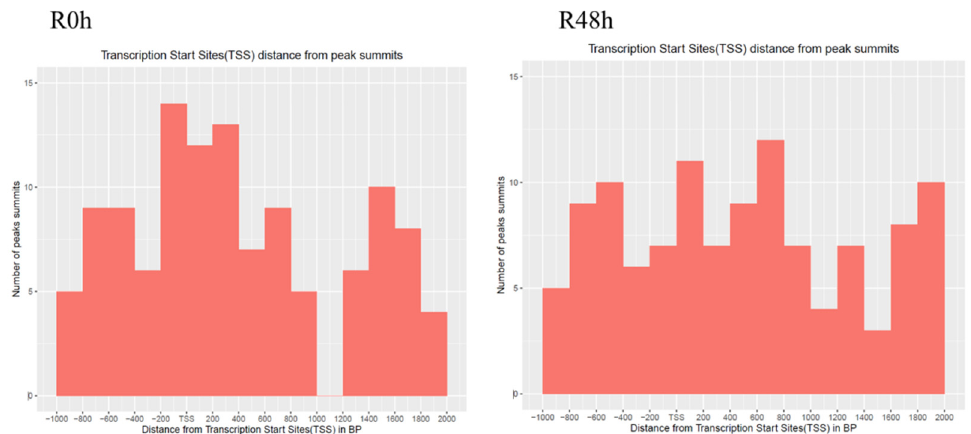
Figure 7. The distance between transcription start sites and MACS peak summits for the gene-associated peaks in R0h and R48h. Table 2. ChIP-seq data reveals peak-associated genes regulated by SmTCP7a.